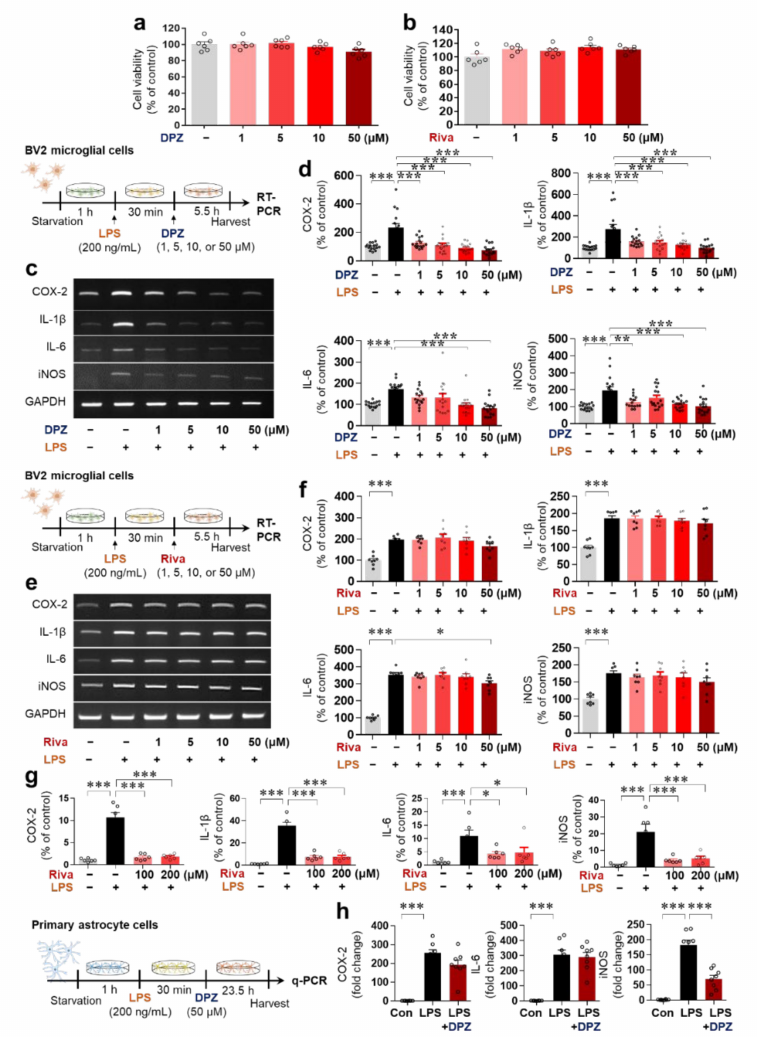
Figure 1. Donepezil ameliorates the induction of proinflammatory cytokines by LPS in BV2 mi- croglial cells and primary astrocytes. ( a , b ) The cytotoxicity of donepezil ( a ) and rivastigmine ( b ) was evaluated by the MTT assay in cells treated with a range of concentrations (1, 5, 10, and 50 µ M) or vehicle (1% DMSO) for 24 h ( n = 6/group). ( c , d ) RT-PCR analysis of proinflammatory cytokine levels in BV2 microglial cells pretreated with LPS or PBS and treated with donepezil or vehicle as shown ( n = 16/group). ( e , f ) RT-PCR analysis of proinflammatory cytokine levels in BV2 microglial cells pretreated with LPS or PBS and treated with rivastigmine or vehicle (1% DMSO) as shown ( n = 8/group). ( g ) q-PCR analysis of proinflammatory cytokine levels in BV2 microglial cells pre- treated with LPS or PBS and treated with 100 or 200 µ M rivastigmine or vehicle (1% DMSO) as in ( e , f ) ( n = 6/group). ( h ) q-PCR analysis of proinflammatory cytokine levels in primary astrocytes pretreated with LPS or PBS and treated with donepezil or vehicle (1% DMSO) as shown ( n = 8/group). * p < 0.05, ** p < 0.01, *** p <